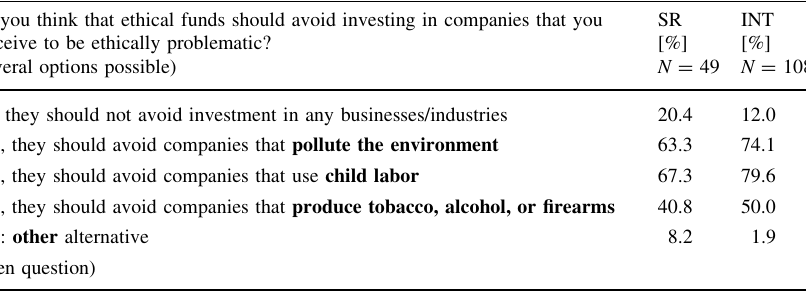
Table 10 Avoidance of ethically problematical